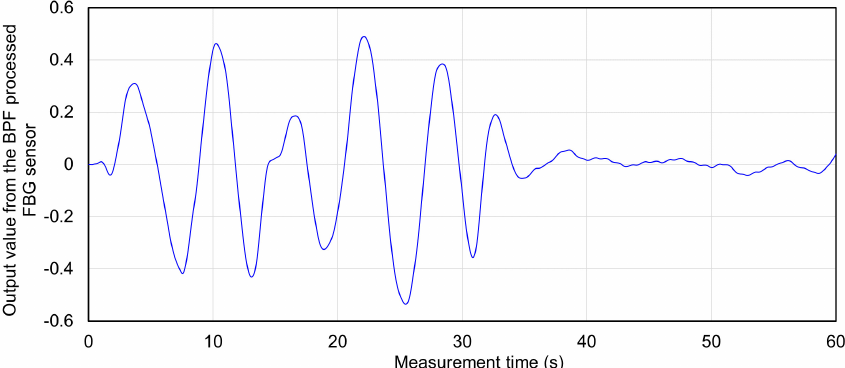
Figure 8. Measured FBG sensor signal during breathing and apnea in 3rd experiment (0–30 s: Breathing five times, 30–60 s: Apnea).